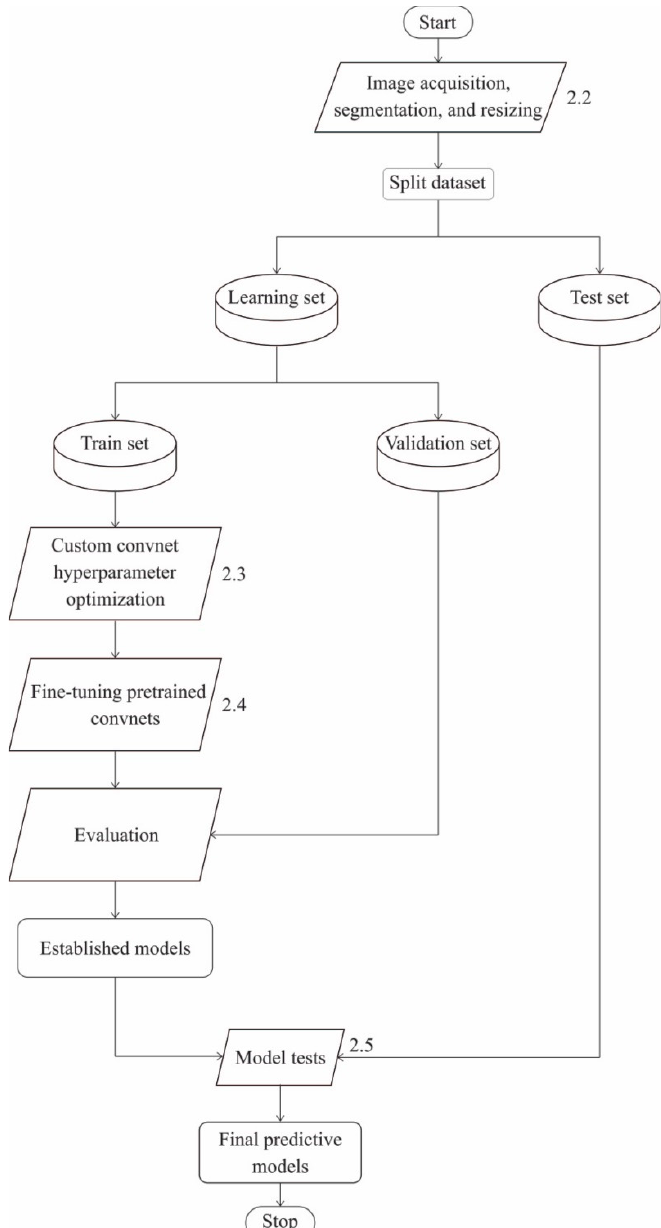
Figure 1. Flowchart depicting the deep-learning procedures and the proposed imaging technology. The numbers on the right side of the rectangles indicate the step in the process. These steps are described in the subsequent sections from 2.2 to